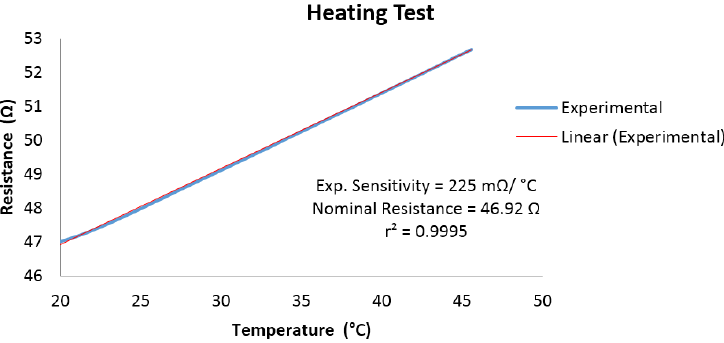
(cooling Test, with respect to temperature).